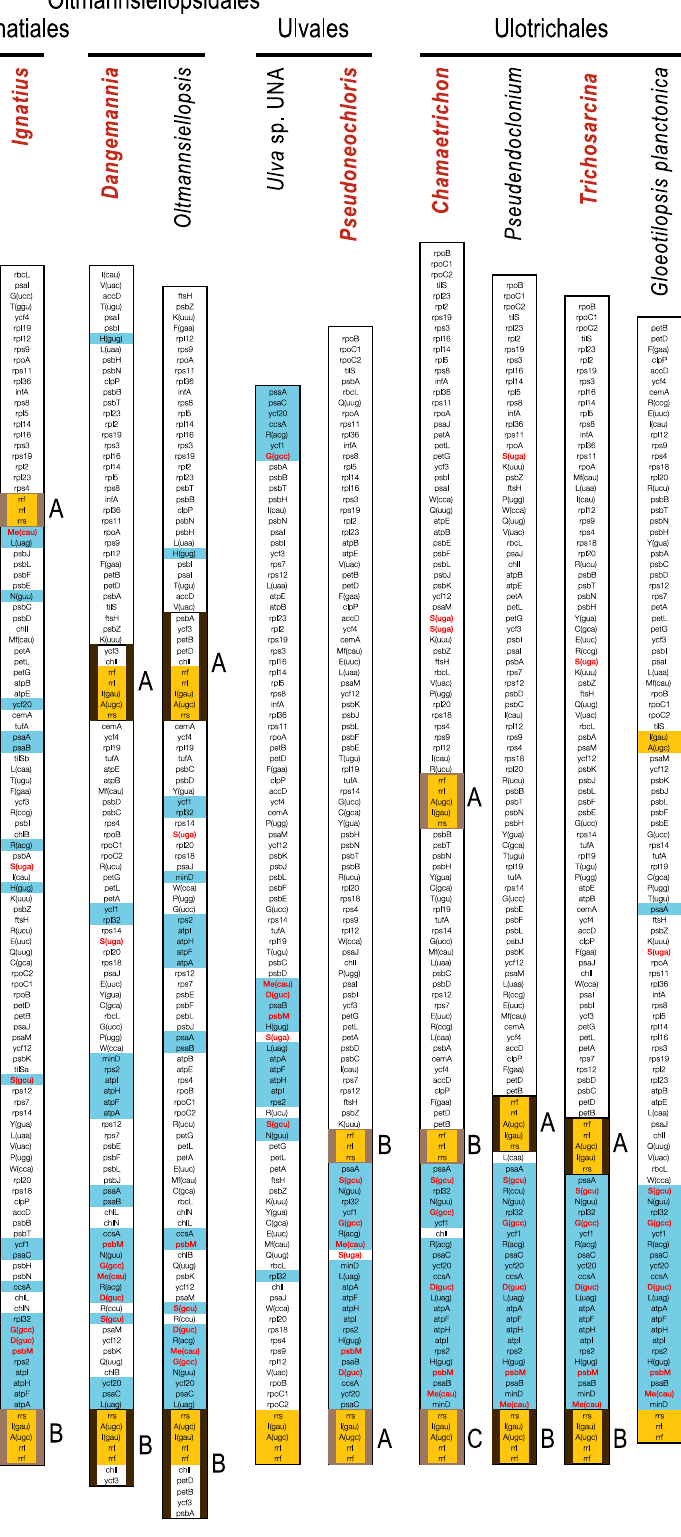
Figure 3. Gene partitioning patterns of ulvophycean chloroplast genomes. The suite of genes in each IR- containing genome is displayed so that the SC region with the gene content the most similar to that predicted for the ancestral SSC region of core chlorophytes is presented at the bottom of the figure. Thick vertical lines delimit the genes encoded in the IR (thick black lines, identical IR copies; thick brown lines, divergent IR copies). The genes making up the rDNA operon are highlighted in yellow whereas those present in the SSC region of Trichosarcina are highlighted in blue. Red letterings designate the genes of ancestral LSC origin that have been acquired by the IRs of core